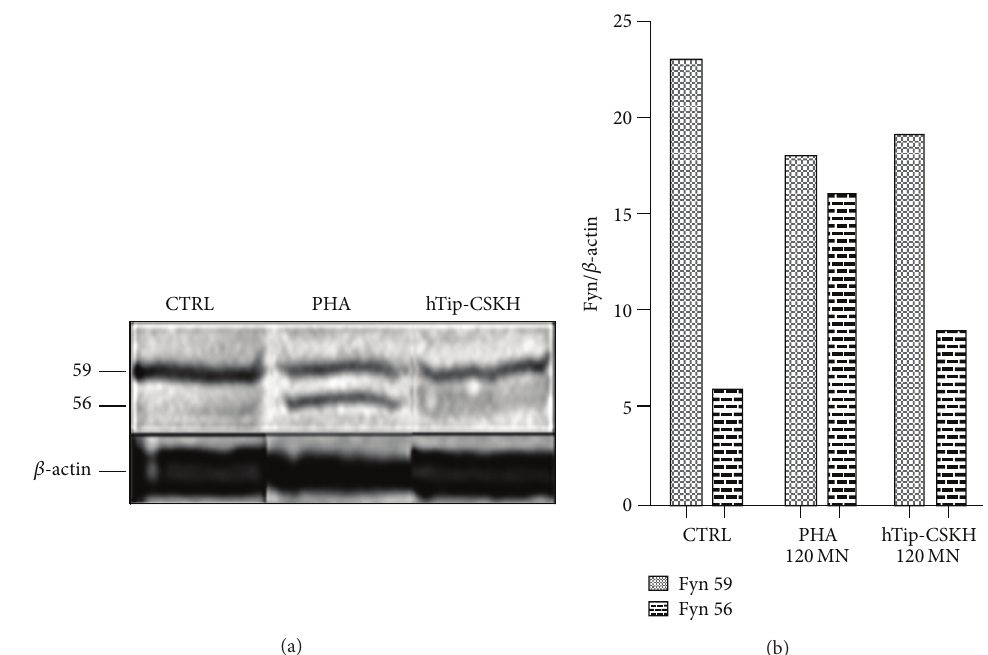
Figure 7: Fyn detection in stimulated human PBMC. (a) PBMC were treated with PHA-P and hTip-CSKH during 2 h, lysed, and the protein extract resolved by SDS-PAGE. Western blot was performed with an anti-Fyn specific antibody. PHA-P was used as positive control, which induces the appearance of a second band of 56 kDa. (b) Quantification of the Fyn p59 and p56 bands. The intensity of each Fyn band was normalized to the loading control 𝛽